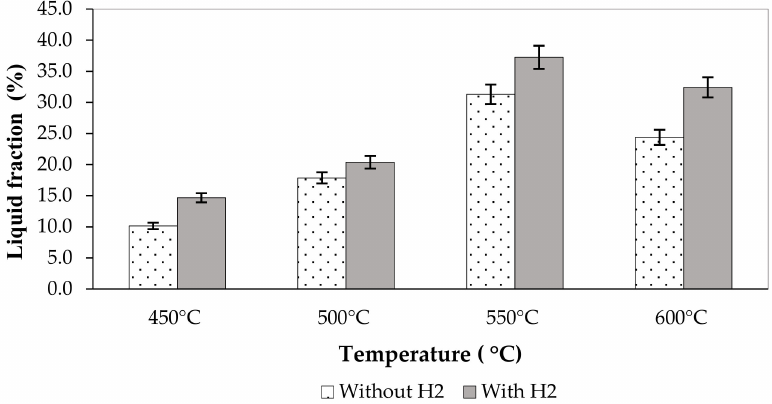
Figure 4. Mass fraction of the liquid fractions obtained at different temperatures with and without a constant flow of